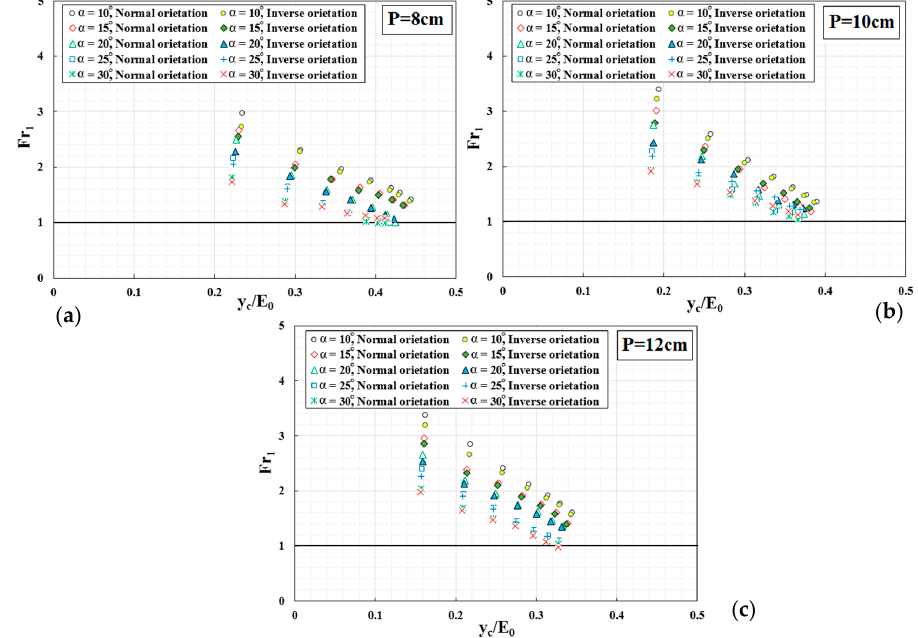
Figure 11. Downstream Froude number ( Fr 1 ) versus the relative critical depth y c / E 0 , ( a ) P = 8 cm, ( b ) P = 10 cm, ( c ) P = 12 cm.